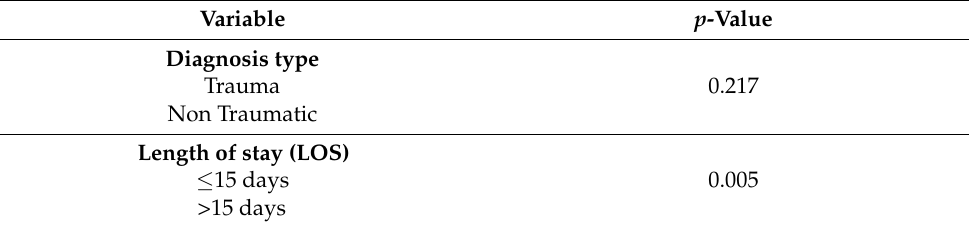
Table 3. The association between type of treatment (surgical vs. conservative) and other